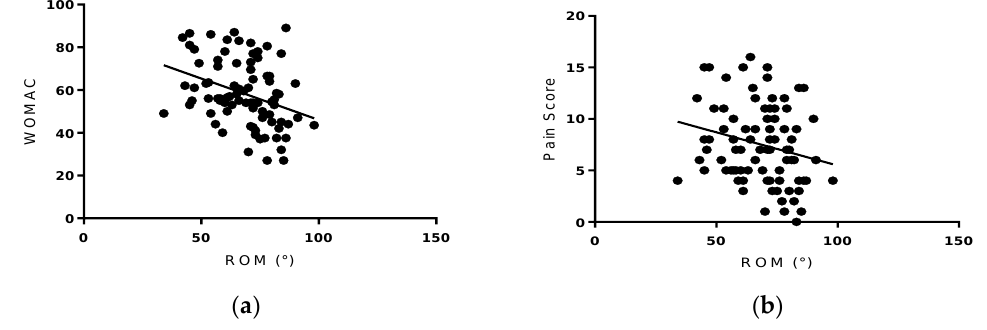
Figure 3. Right panel ( a ): WOMAC score vs. ROM. Individuals with a lower WOMAC score had greater knee ROM ( r = − 0.338, p = 0.002). Left panel ( b ): pain score vs. ROM. Individuals with a lower pain score had a greater knee ROM ( r = − 0.222, p = 0.002).